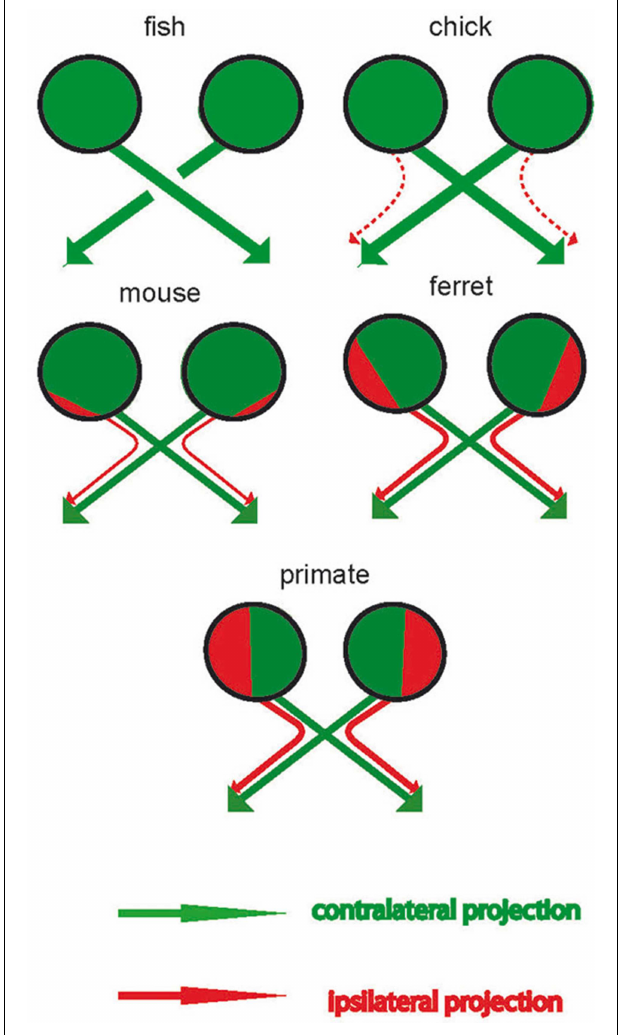
FIGURE 2 | In fish, except Cyclostomes, all retinal ganglial cells project contralaterally and retinal axons do not intermingle at the chiasm. In birds, retinal axons project contralaterally, however, there is a minor transient ipsilateral projection (red dashed lines) that disappears at hatching. Binocular vision is partially developed in mouse and ferret with most retinal axons crossing the midline (green), but they also possess ipsilateral retinal projections (red). Binocular vision is fully developed in mammals with frontally located eyes. Line thickness indicates the proportions of fibers that projects to ipsilateral or contralateral targets. Reprinted from Herrera and Mason (2007) with permission from Elsevier and the